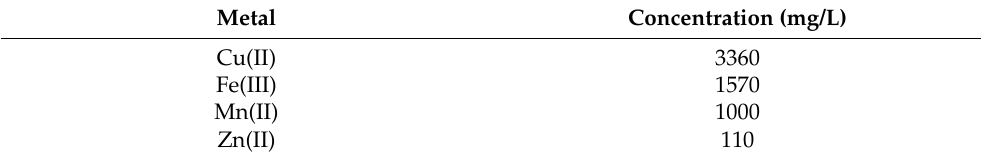
Table 1. Concentration of metals in synthetic solution (pH = 2, sulfate = 8.65